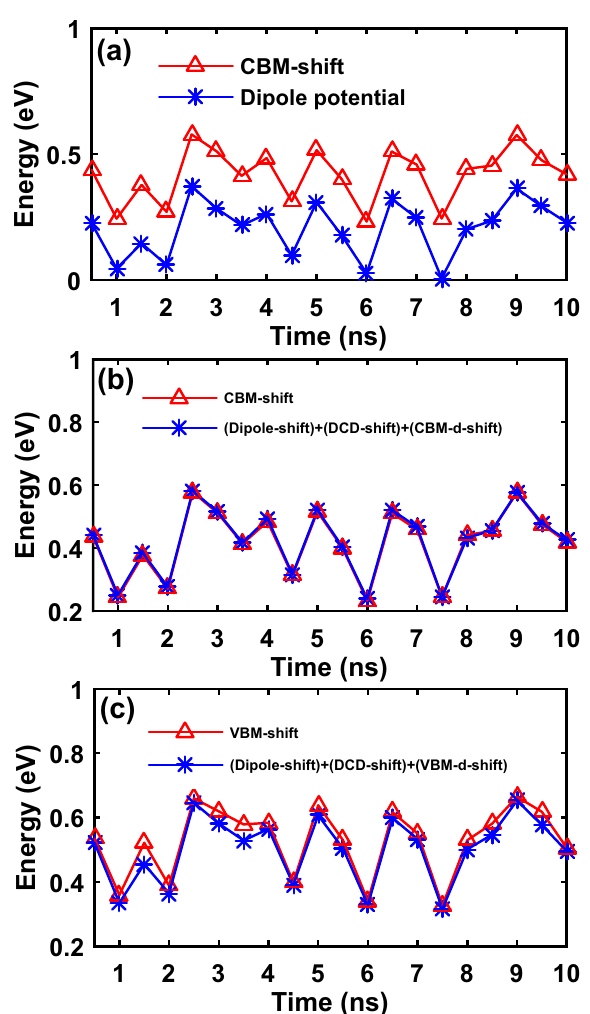
Fig. 4 Microscopic contributions to the band edge shift. a The comparison of total CBM shift with the potential shift induced by water dipole effect. b The comparison of total CBM shift with the sum of band edge shifts caused by the water dipole effect, the charge redistribution effect and the geometric deformation effect. c The comparison of total VBM shift with the sum of band edge shifts caused by the water dipole effect, the charge redistribution effect and the geometric deformation effect. Here CBM-d-shift and VBM-d- shift is the difference between the CBM (VBM) of distorted MoS 2 and pristine MoS 2